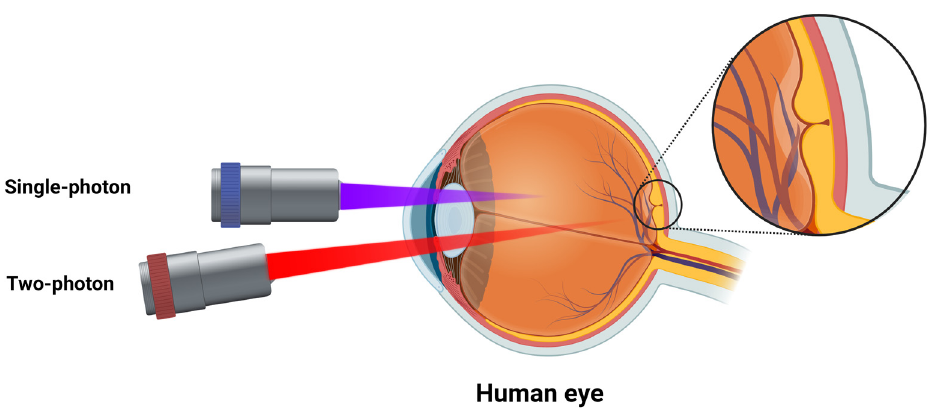
Figure 6. Illustration of one- and two-photon penetration power in retinal